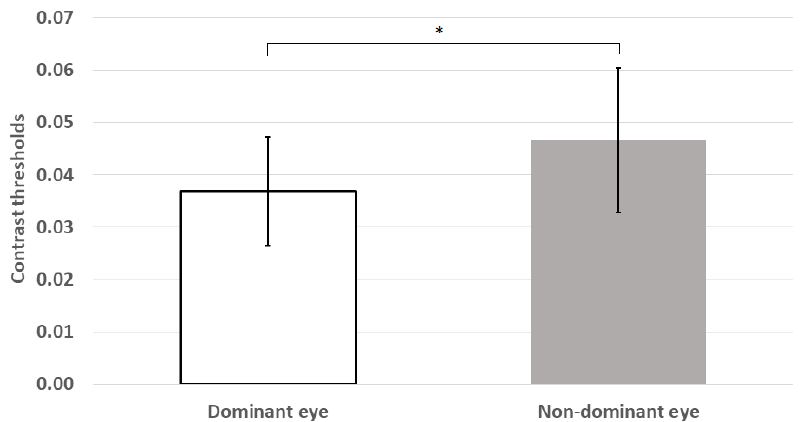
Figure 3. Mean contrast thresholds were significantly lower for the dominant eye than those for the non-dominant eye. * p < 0.05; error bars represent ± 1 standard deviation.